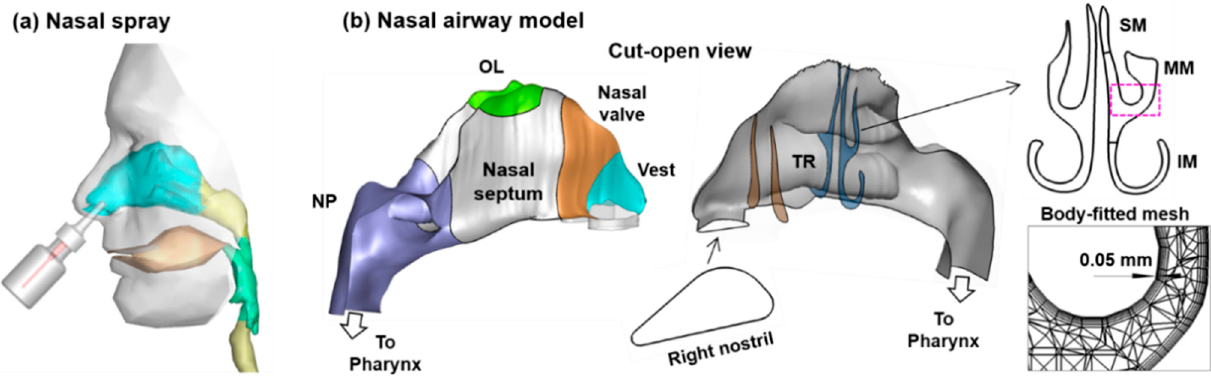
Figure 1. Nasal spray modeling: ( a ) diagram of nasal spray application and ( b ) MRI-based nasal airway model with a cut-open view to reveal the nasal septum and turbinate (conchae) in the right passage. To characterize intranasal spray distribution, the nasal cavity is divided into different sub-regions: vestibule (Vest), nasal valve, turbinate (TR), olfactory region (OL), and nasopharynx (NP). The airspace in the TR region is termed meatus, which is divided into superior meatus (SM), middle meatus (MM), and inferior meatus (IM). Fine prismatic mesh is generated in the near-wall region with the first layer height being 0.05 mm.